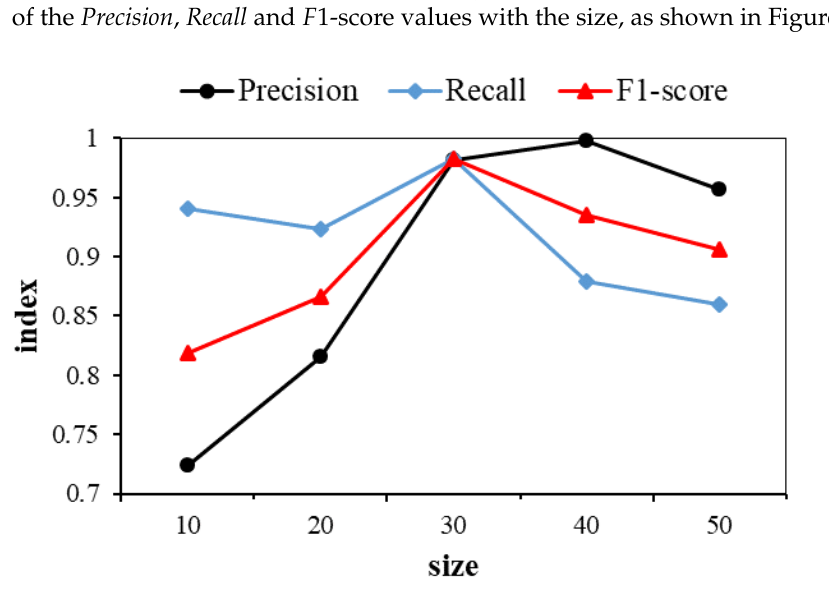
Figure 6. Effect of size on Precision , Recall and F